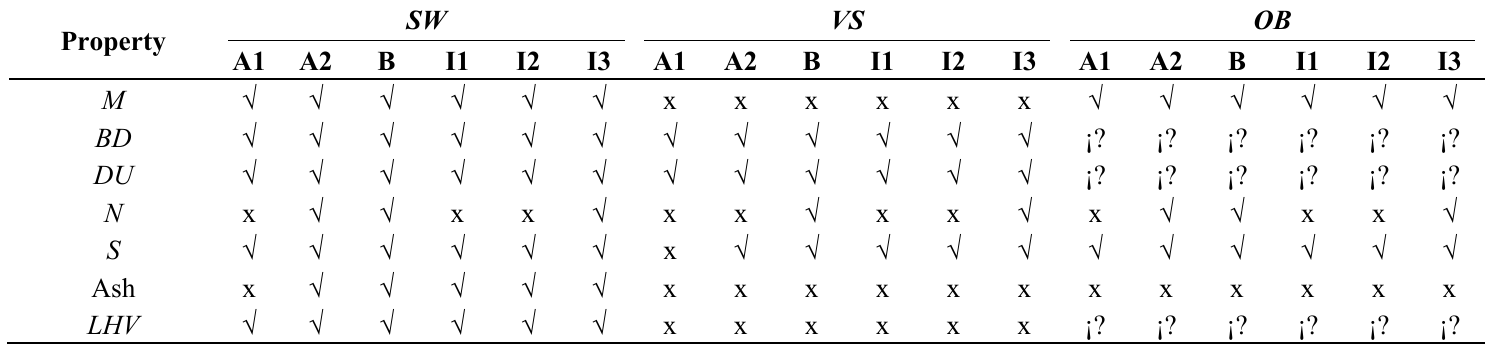
Table 6. Comparison with EN ISO 17225-2 standard (part